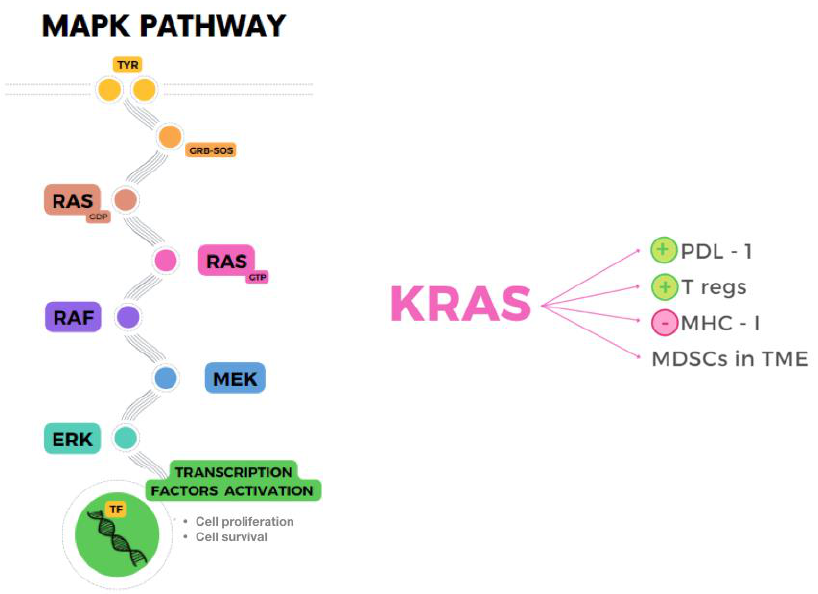
Figure 2. MAPK pathway ( left ) and immunosuppressive role of KRAS ( right ) mediated by upregulation of PDL-1, increased Tregs and MDSCs in TME, and downregulation of MHC-I.